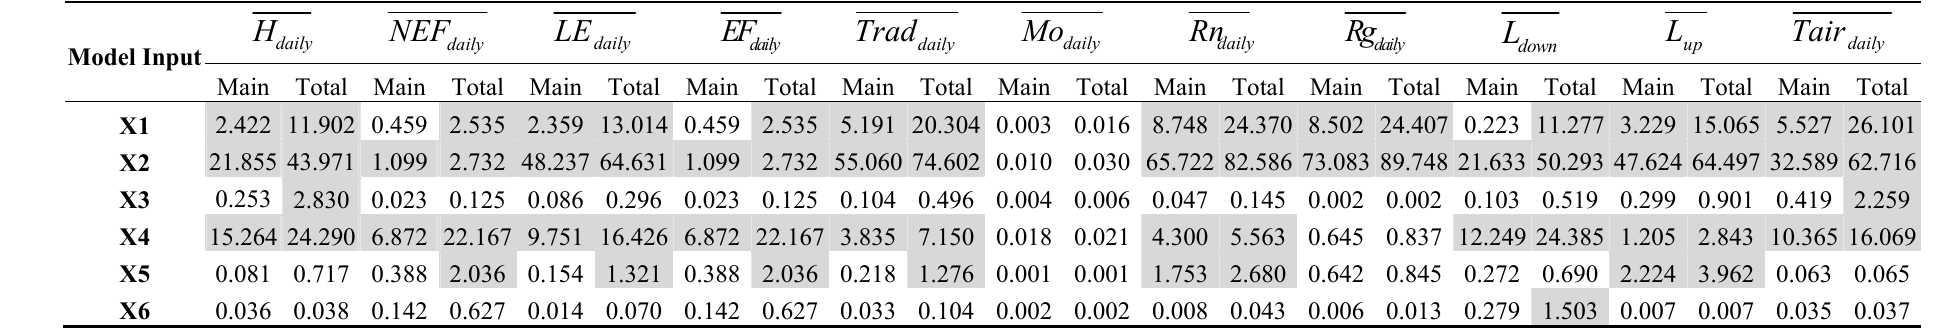
Table 5. Summarised results from the implementation of the BACCO GEM-SA method on the different outputs simulated by SimSphere using uniform PDFs at 09:30. Computed main (Main) and total effect (Total) indices by the GEM tool (expressed as %) for each of the model parameters are shown, whereas the last three lines summarise the percentages of the explained total output variance of the main effects alone, the 1st order interactions only (1st) and the 2nd or higher order interactions only (>1st). Input parameters with a variance decomposition of greater than 1% are